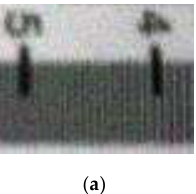
Figure 6. Details of the original tilting image and the restored tilting image. ( a ) Details of the original tilting image; ( b ) details of the restored tilting